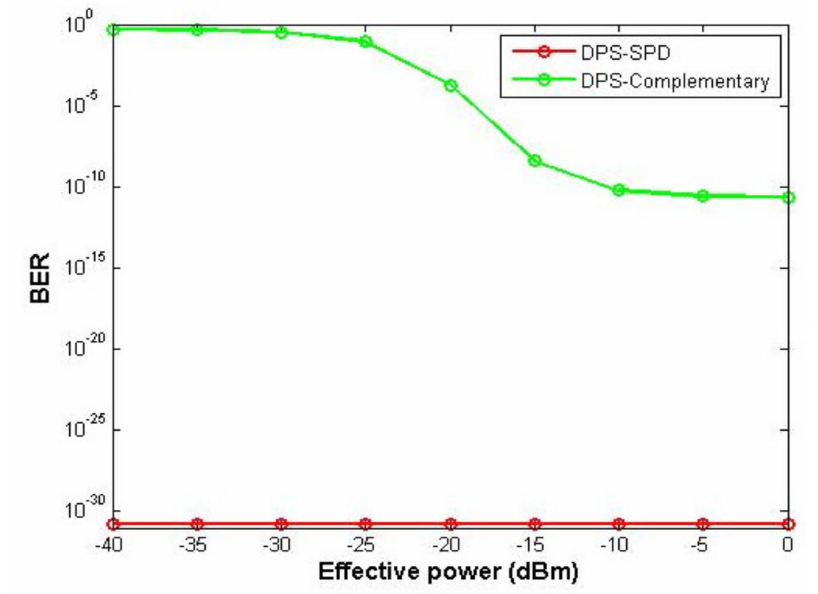
Figure 6. BER versus effective power for DPS code using different detection techniques and at 622 Mbps and 60